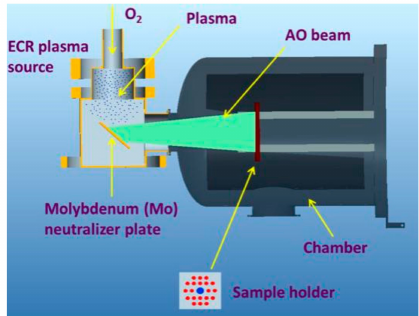
Figure 1. Atomic oxygen (AO) generation and measurement mechanism in the current